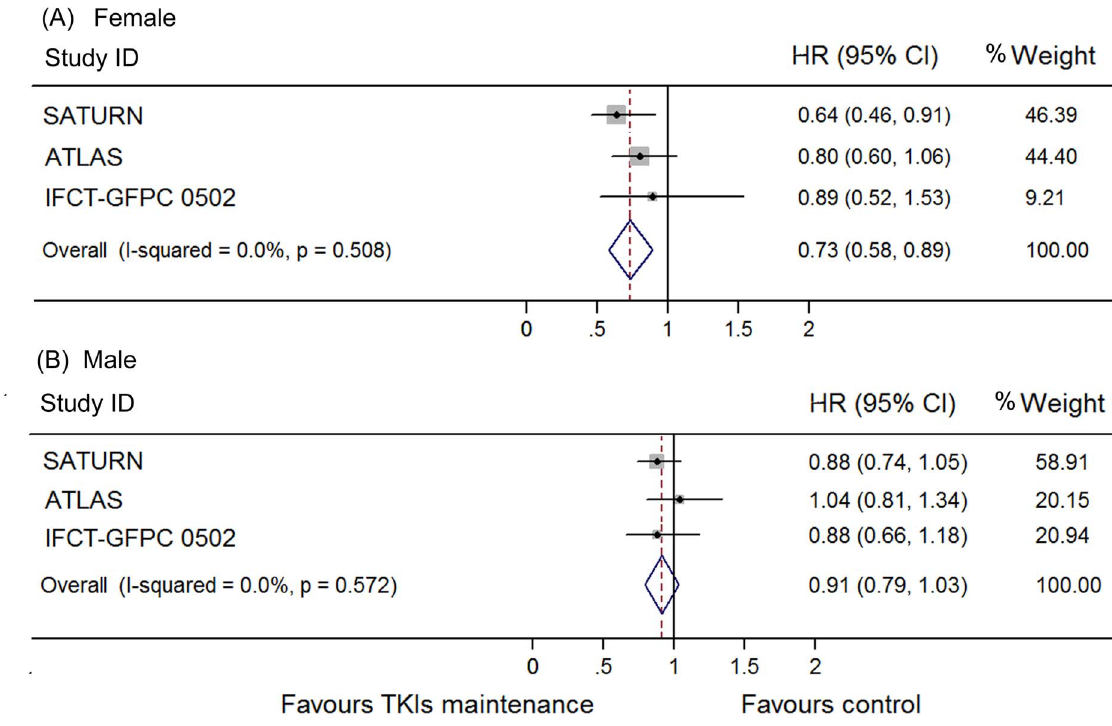
Figure 5. Meta-analysis of hazard ratio (HR) for overall survival (OS) according to sex. (A) Female. (B) Male.